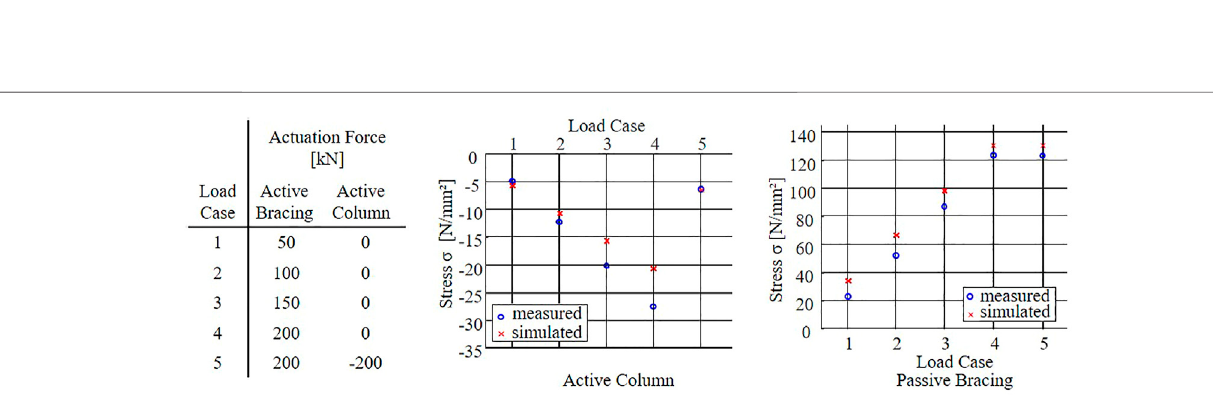
FIGURE 10 | Structure of the active column (left) and prototype (right) (Source: IKTD).